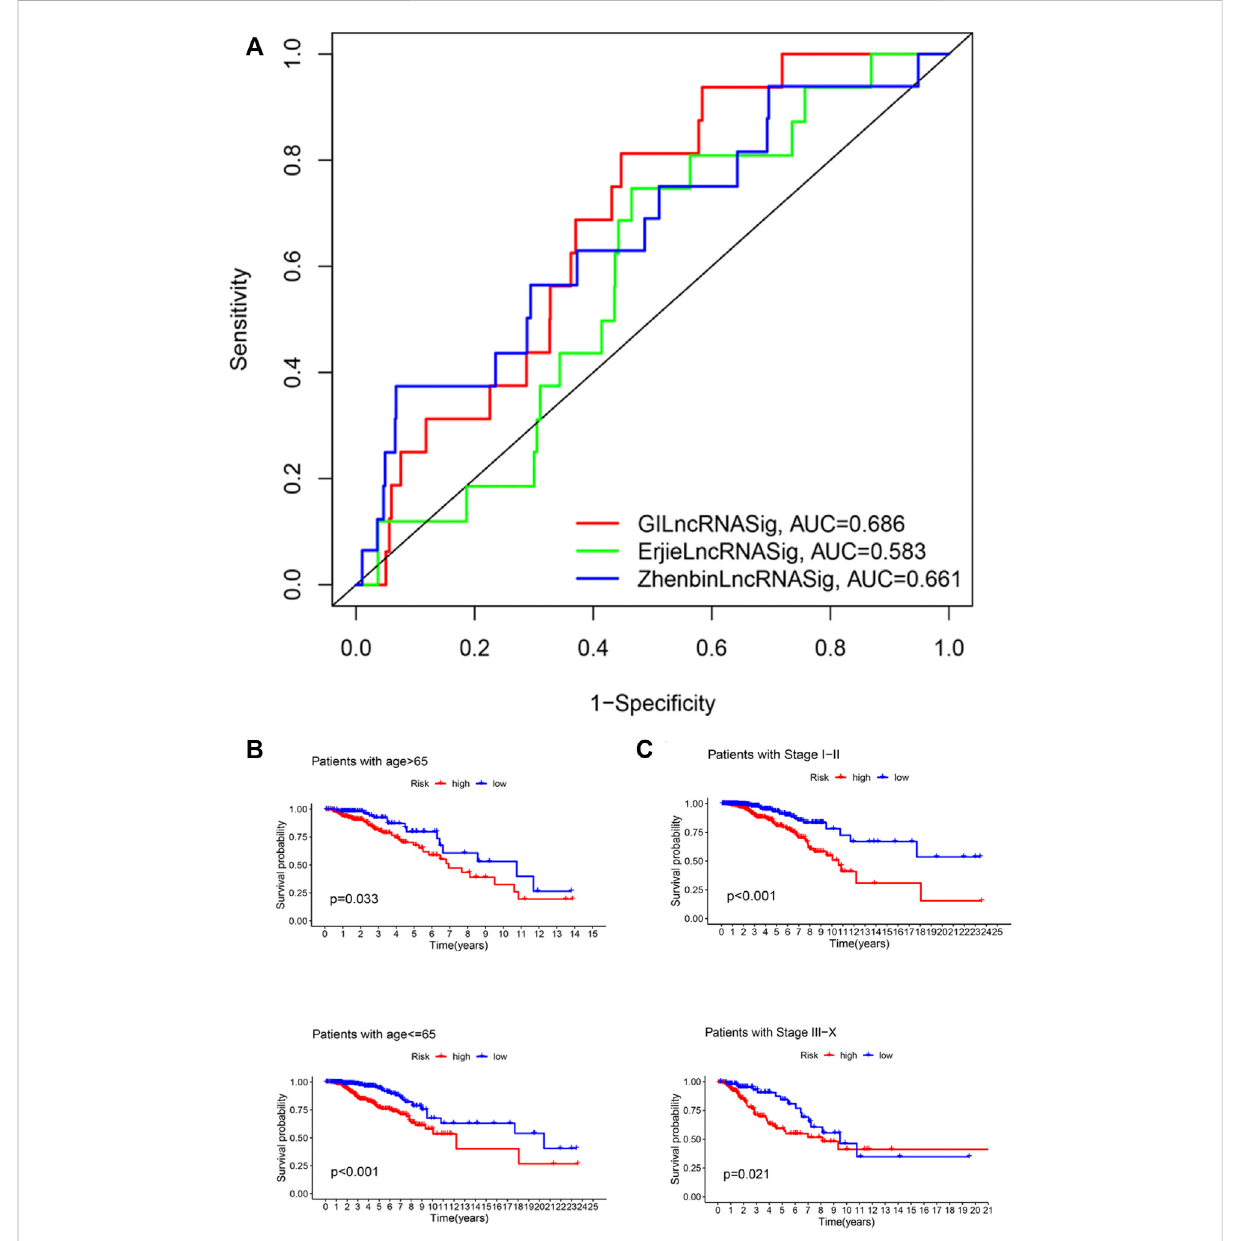
FIGURE 5 Identi fi cation of the ef fi ciency of GILncRNASig in clinical characteristics. (A) . Comparison of the time-dependent ROC curve with other characteristic-related lncRNAs model. (B) . Kaplan – Meier curves of overall survival of patients between low- and high-risk groups in patients